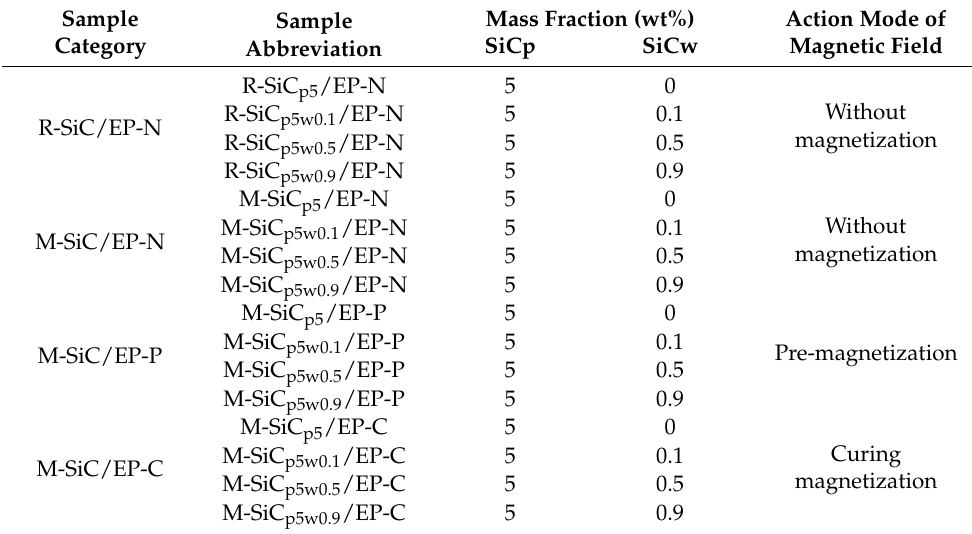
Table 2. Types and abbreviations of SiC/EP